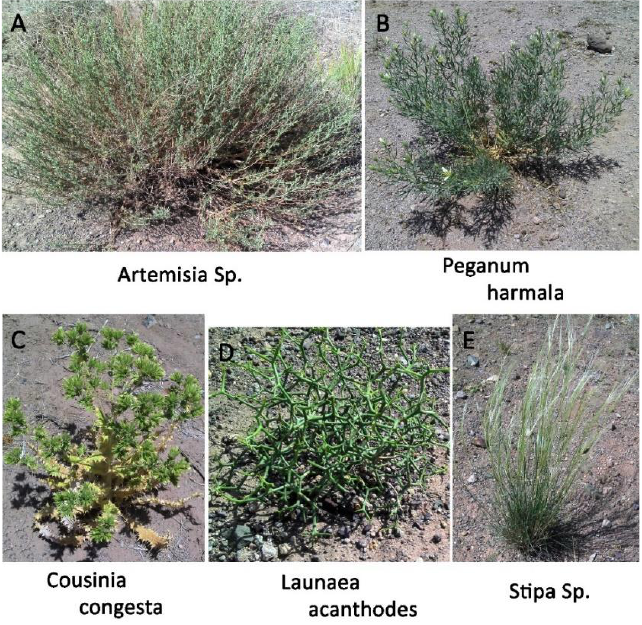
Figure 2. Selected plant species: Artemisia sp. ( A ), Peganum harmala ( B ), Cousinia congesta ( C ), Launaea acanthodes ( D ), and Stipa sp. ( E ).